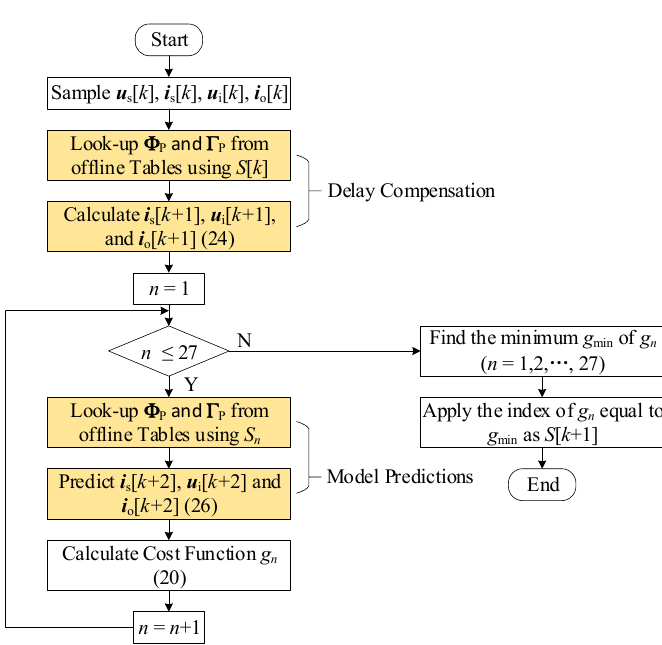
Figure 4. Control flowchart of the improved MPC with the precise prediction model.